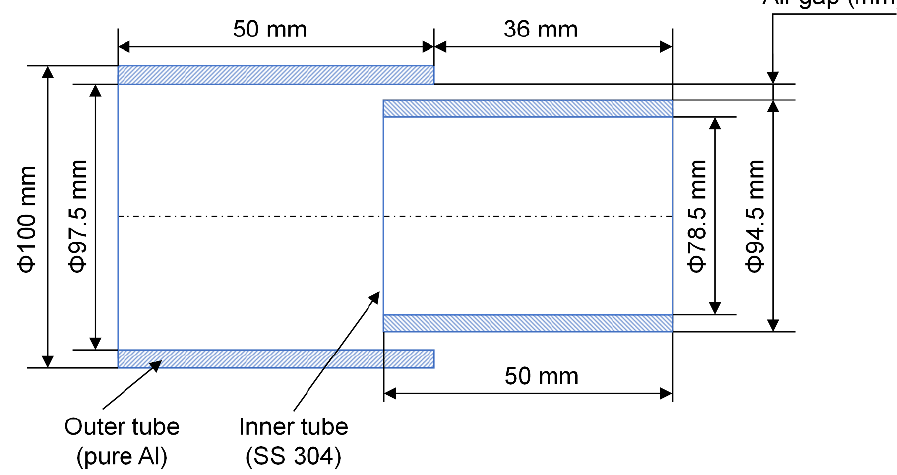
Figure 3. Arrangement of flyer and target tubes.